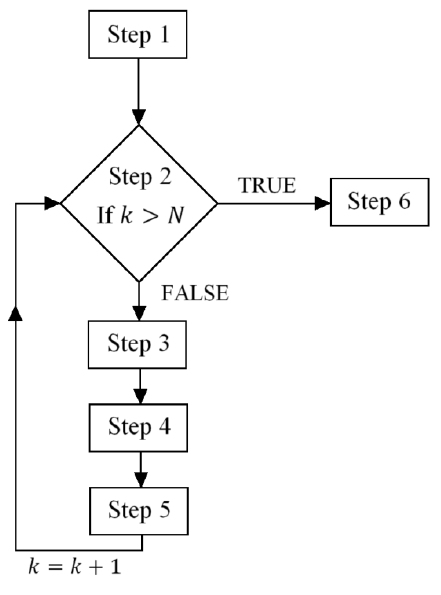
Figure 3: Flow chart of the numerical algorithm. Detailed descriptions of the steps are in the